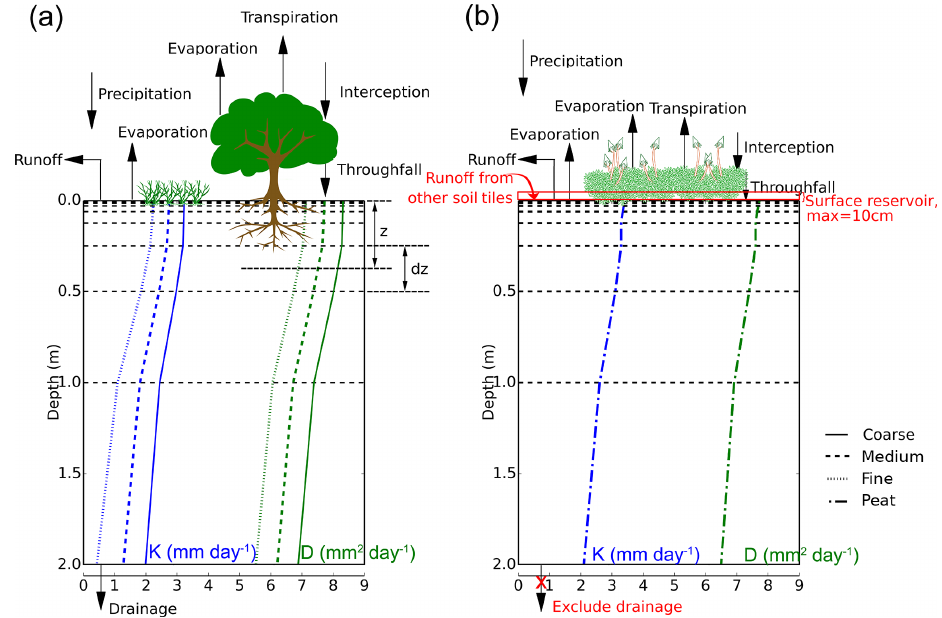
Figure 1. Schematic of the hydrology module in ORCHIDEE. Water balance components: (a) a soil tile with either trees or grasses; (b) a peatland soil tile. Black dashed lines indicate the position of nodes in the 11 soil layers of the model. Blue lines: vertical profiles of saturated hydraulic conductivity for different soil textures. Green lines: diffusivity for different soil textures. The vertical axis indicates soil depth, the horizontal axis indicates values of saturated hydraulic conductivity ( K , mmday − 1 ) and diffusivity ( D , mm 2 day − 1 ). Note that the horizontal axis is on a base-10 logarithmic scale.